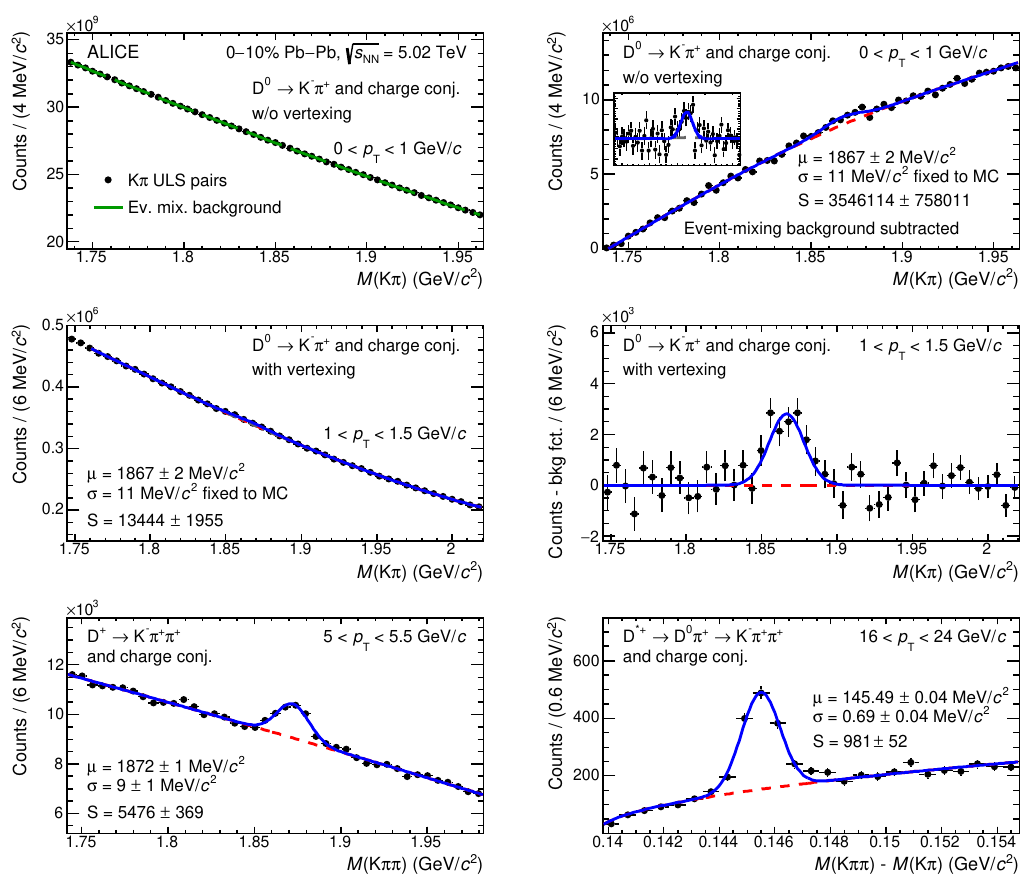
Figure 1 . Invariant-mass (mass-difference) distribution of D 0 , D + , and D ∗ + meson candidates in different p T intervals for the centrality class 0–10%. The fit functions are composed of a Gaussian function for the signal and an additional term for the background, as described in detail in the text. The values for the Gaussian mean µ , width σ , and raw yield S are also reported. Top row: D 0 -meson candidates with 0 < p T < 1 GeV /c without reconstructing the decay vertex. The invariant-mass distributions are shown before (left) and after (right) the subtraction of the combinatorial back- ground estimated from event-mixing. Middle row: D 0 -meson candidates with 1 < p T < 1 . 5 GeV /c with reconstruction of the decay vertex before (left) and after (right) background subtraction. The width of the Gaussian in this and in the previous p T interval is fixed to the value obtained from simulations. Bottom row: D + -meson candidates with 5 < p T < 5 . 5 GeV /c (left) and D ∗ + -meson candidates with 16 < p T < 24 GeV /c